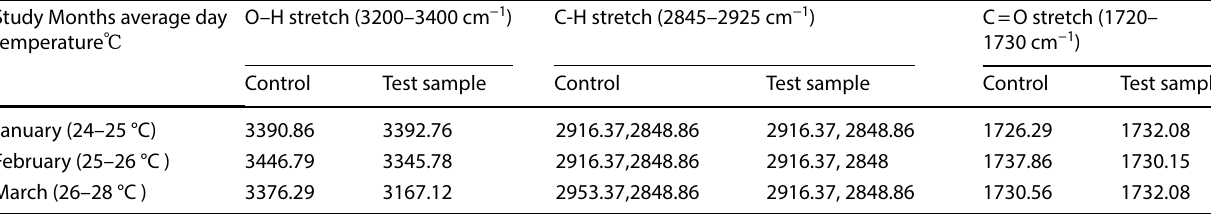
Table 2 FTIR-HATR data of the leaf surface